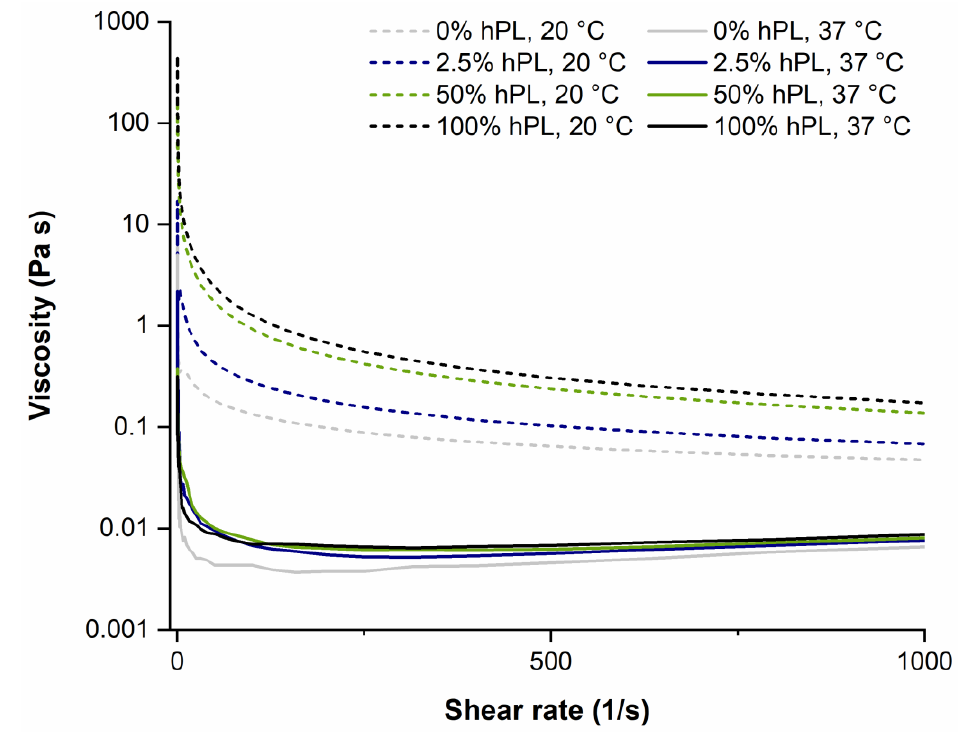
Figure 4. The viscosity of GelMA (5% w/v, DoF of 50%) containing 0%, 2.5%, 50%, and 100% hPL at 20 °C and 37 °C.